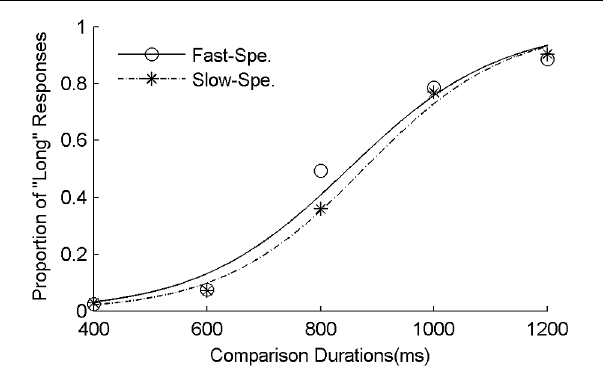
FIGURE 1 | Mean proportions of “Long” responses plotted against probe durations and fitted psychometric functions for the fast-speed words and slow-speed words conditions. The dashed curve and asterisks represented the slow-speed word condition, the solid curve and circles the fast-speed word